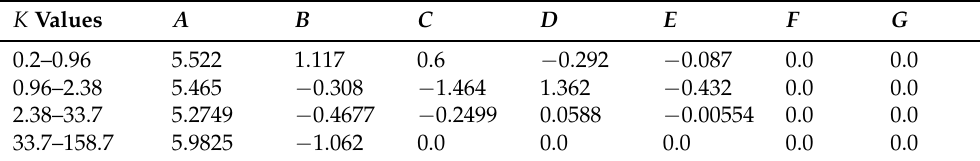
Table 5. Parameters for Equation (7) for incident impulse (from